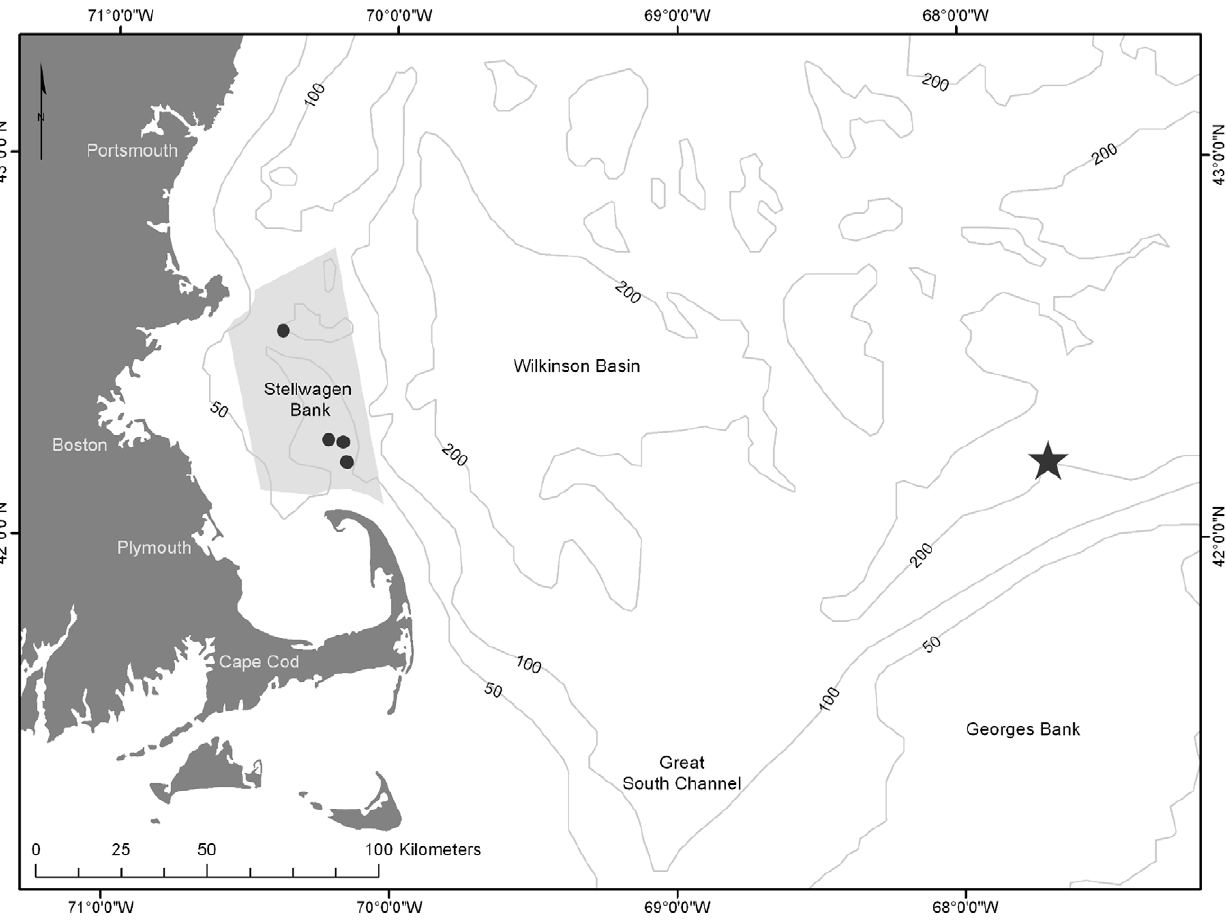
Figure 1. Map of study area (Stellwagen Bank National Marine Sanctuary, shaded in grey) in relation to the location of the moored OAWRS source, as deployed on October 1–3, 2006 (Gong etal. 2010). Star indicates approximate OAWRS source location (42.2089 N, 67.6892 W). Dots indicate locations of all MARUs that were used for analysis in 2006, 2008 and 2009. Map projection: Mercator.